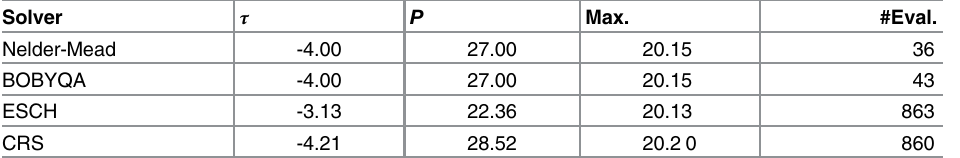
Table 2. Maxima found by different solvers for n = 100 inputs. Objective was to find the parameter combi- nation with the best score (performance optimization). Solver τ P Max. #Eval.